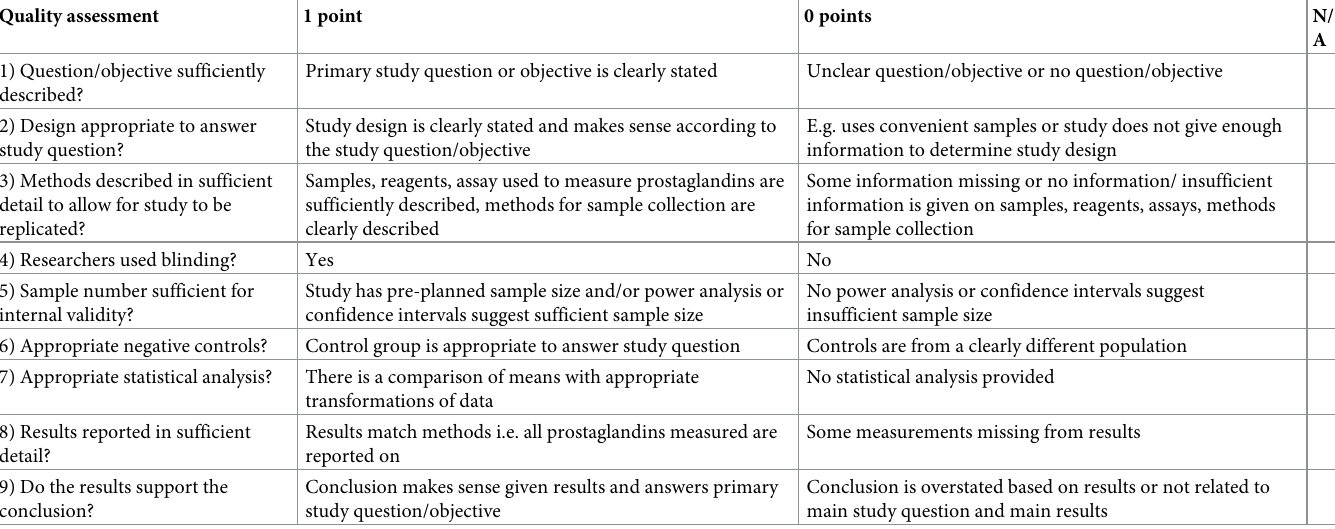
Table 1. Quality assessment